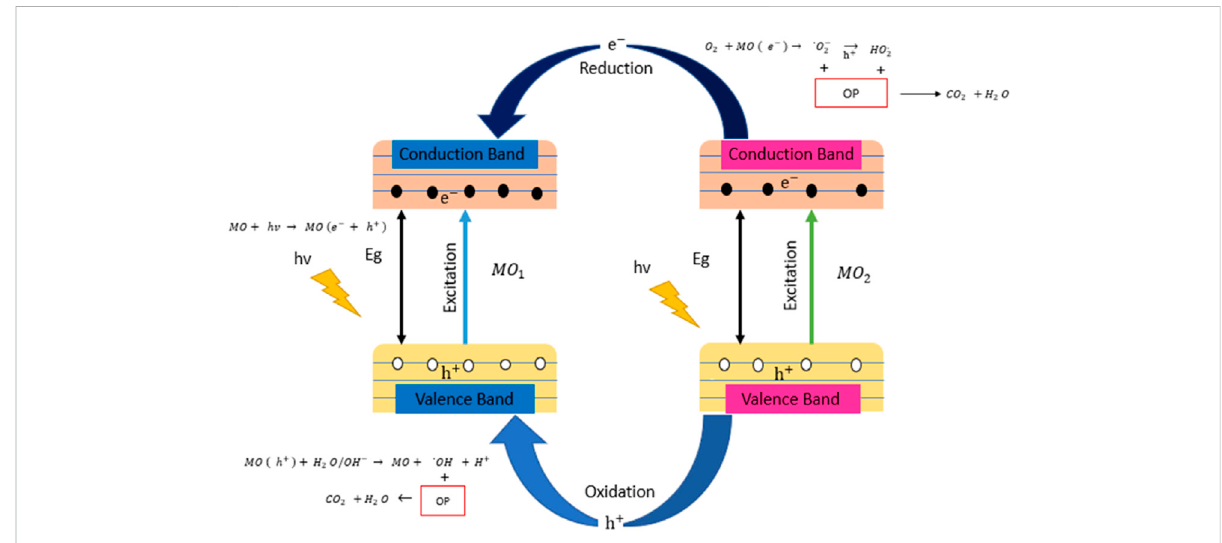
FIGURE 8 Illustration of the photodegradation of the pollutant by hybrid metal oxide photocatalyst nanomaterial. MO, metal oxide